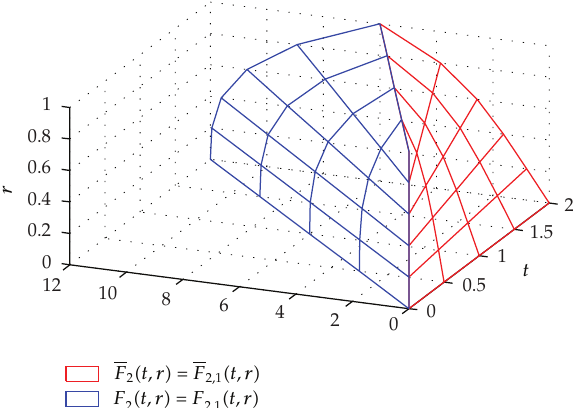
(cid:6) t,r (cid:7) for Example 2 , 1